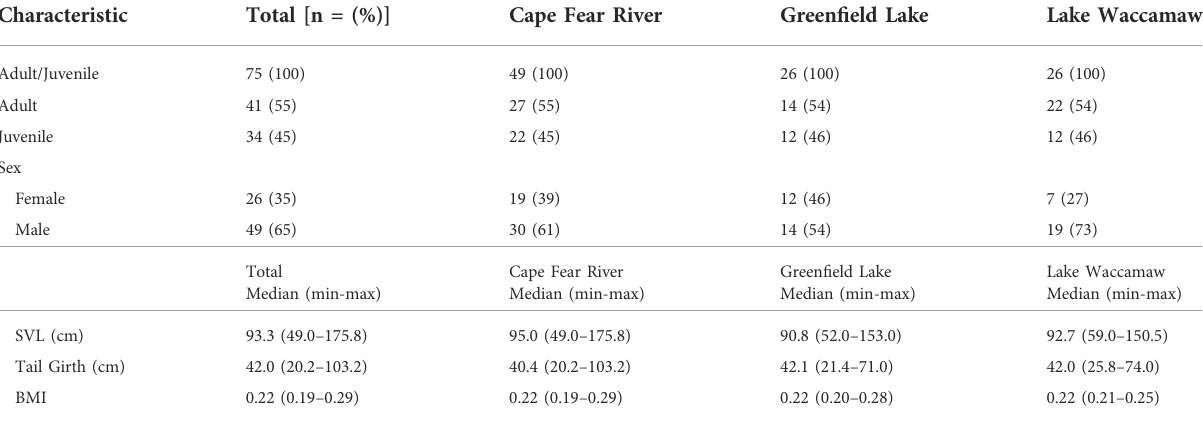
TABLE 1 Characteristics of alligators analyzed.